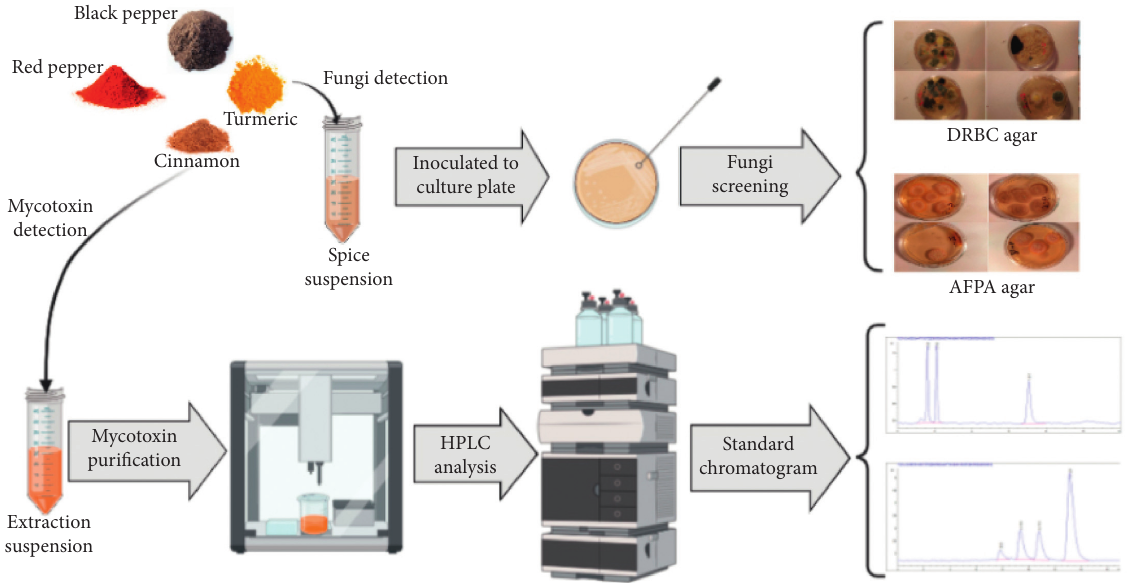
Figure 1: Graphical scheme of analytical methods for the determination of aflatoxin and ochratoxin in